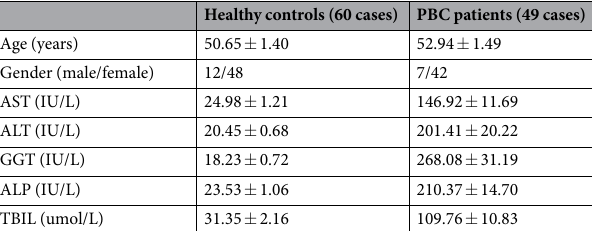
Table 1. Clinical characteristics of the individuals enrolled in the study. Data are presented as mean ± SEM. AST, aspartate aminotransferase; ALT, alanine aminotransferase; GGT, gamma-glutamyl transferase; ALP, alkaline phosphatase; TBIL, total Serum and Salivary AMA-M2 Detection. The levels of serum AMA-M2 in PBC patients and HC subjects were determined by enzyme-linked immunosorbent assay (ELISA) (Euroimmun, Germany) according to the manufacturer’s instructions. To assess the levels of salivary AMA-M2, saliva samples were diluted with 0.1% Bull Serum Albumin-Phosphate Buffer Solution (BSA-PBS) (1:40). Subsequently, two-fold serial dilutions of the top standard from the ELISA kit